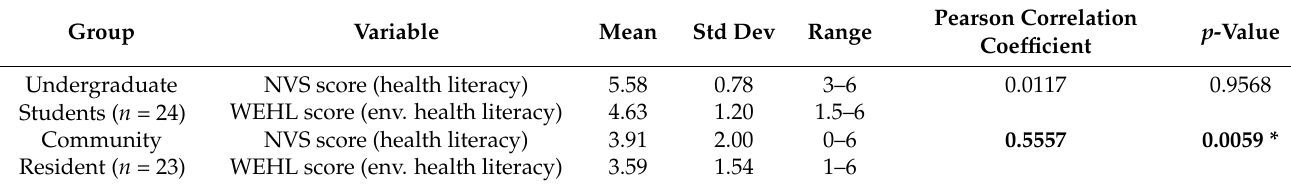
Table 2. NVS and WEHL scores for groups.